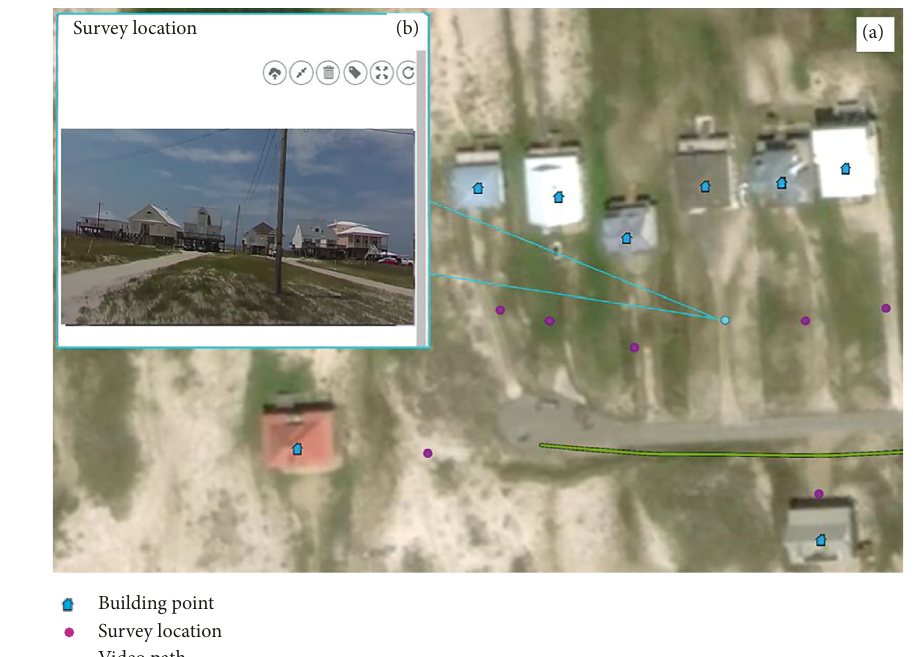
Figure 2: Data visualization in the Extreme Events Web Viewer for survey locations and 360 ° videos.